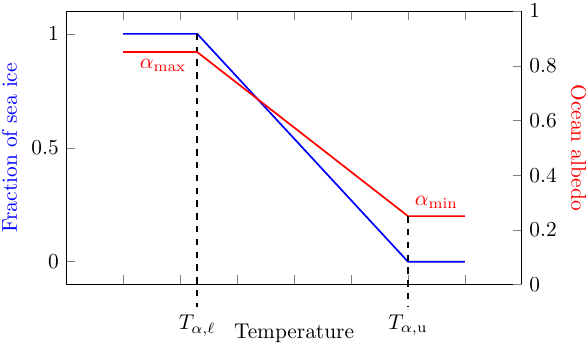
Figure 2. Fraction of sea ice cover (blue) and ocean albedo (red) as a function of temperature T . The ocean albedo is a weighted average of the albedo of open water and of ice, and is therefore directly dependent on the fraction of sea